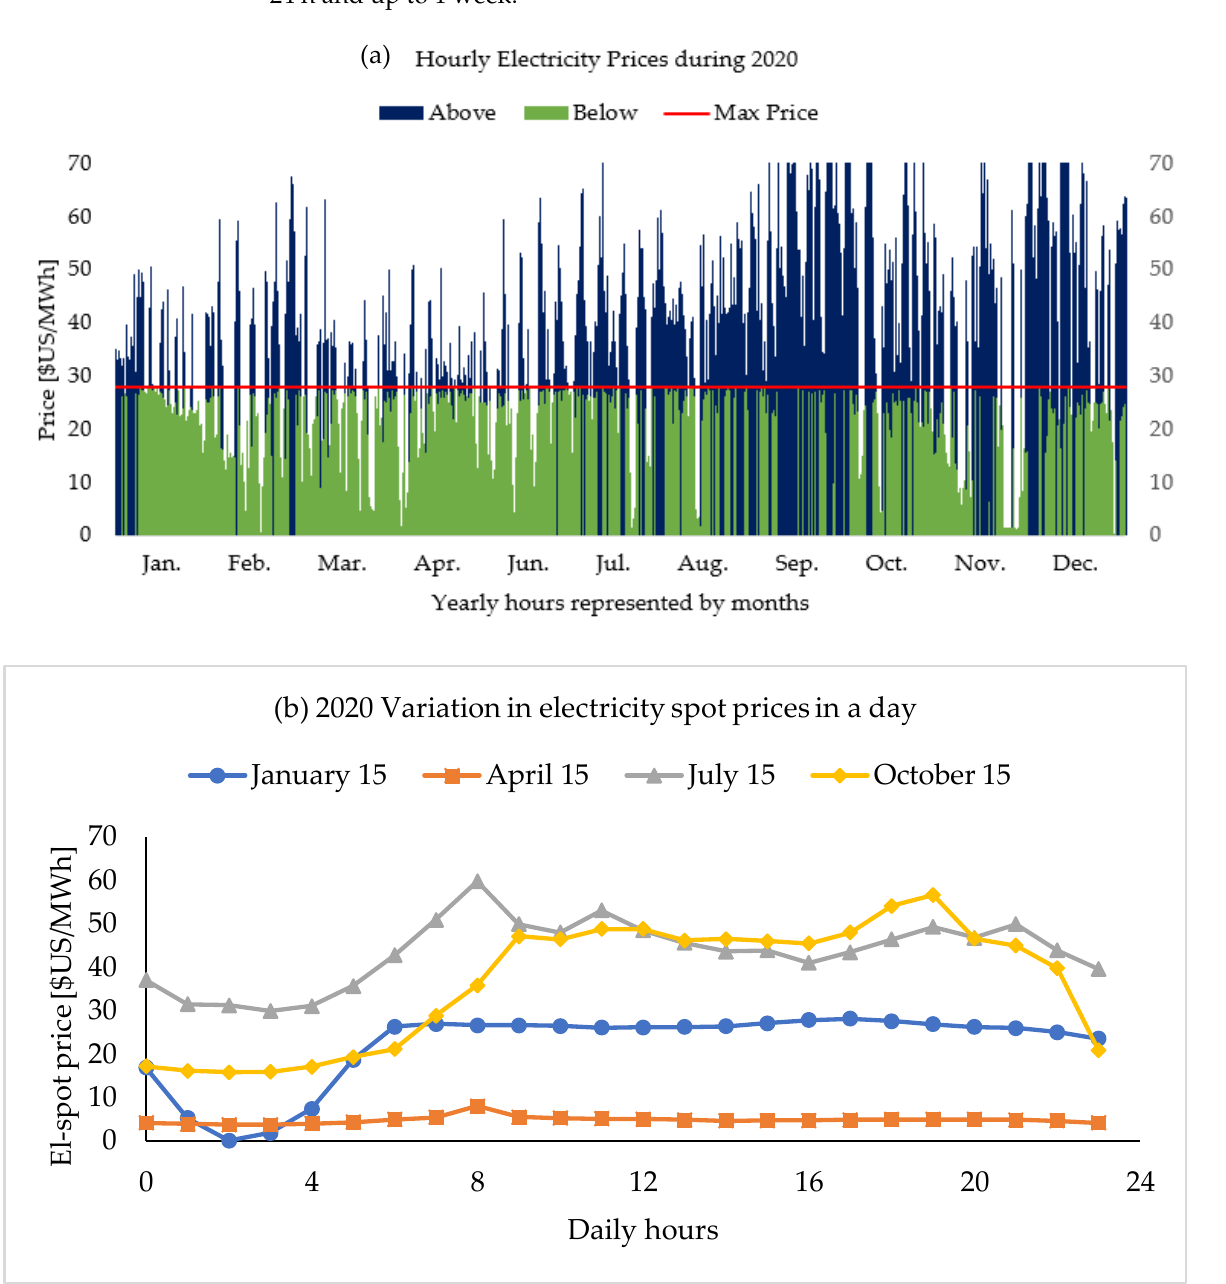
Figure 1. Illustration of the variation in electricity spot prices. ( a ) A representation of the electricity spot price variation that can occur during a full calendar year. ( b ) Variation that can occur during a 24-h period. Data used for this figure was from Nord Pool [16].